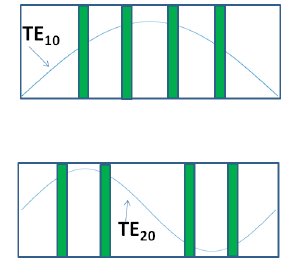
Figure 8: Field distribution for fundamental and second modes. Fin line cards are the green rectangular.